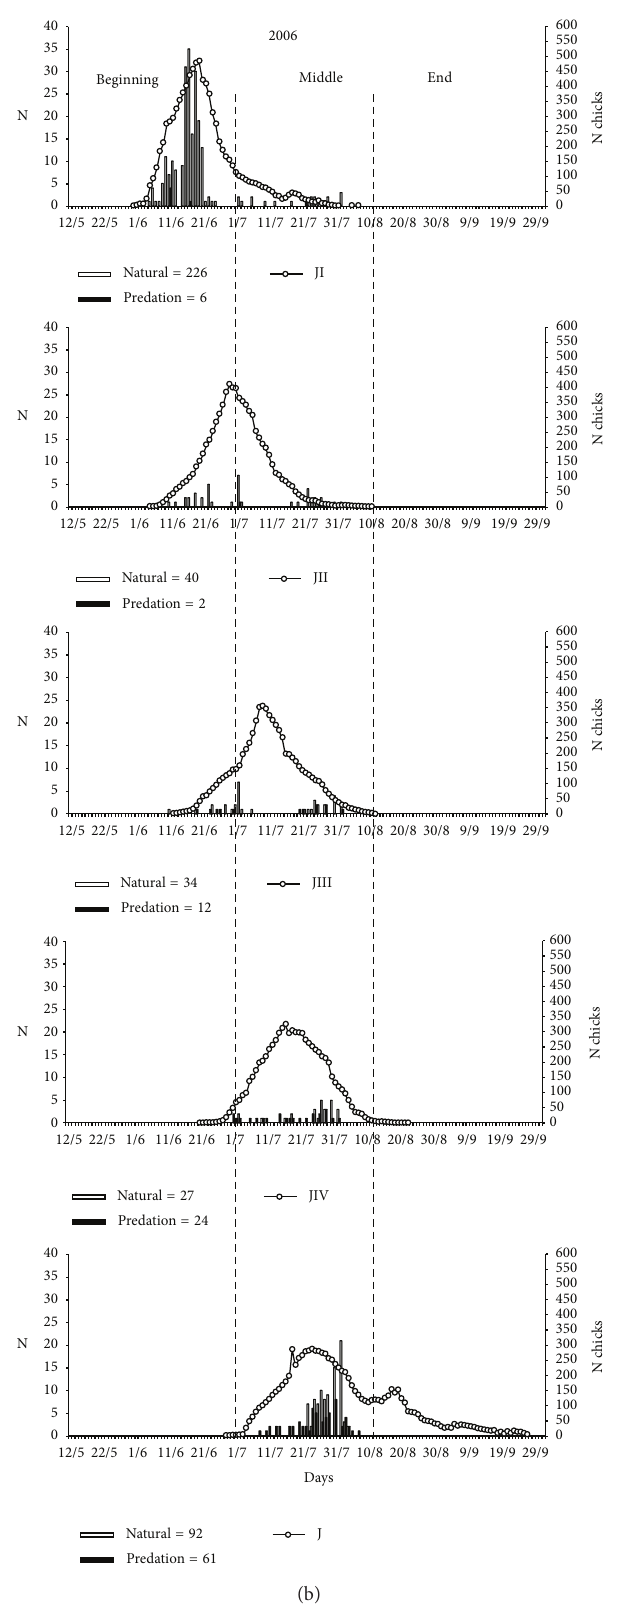
Figure 8: Abundance, mortality by natural causes, and daily predation of young of Sterna hirundinacea at Ilha dos Cardos during the reproductive phases of 2003, 2005, and